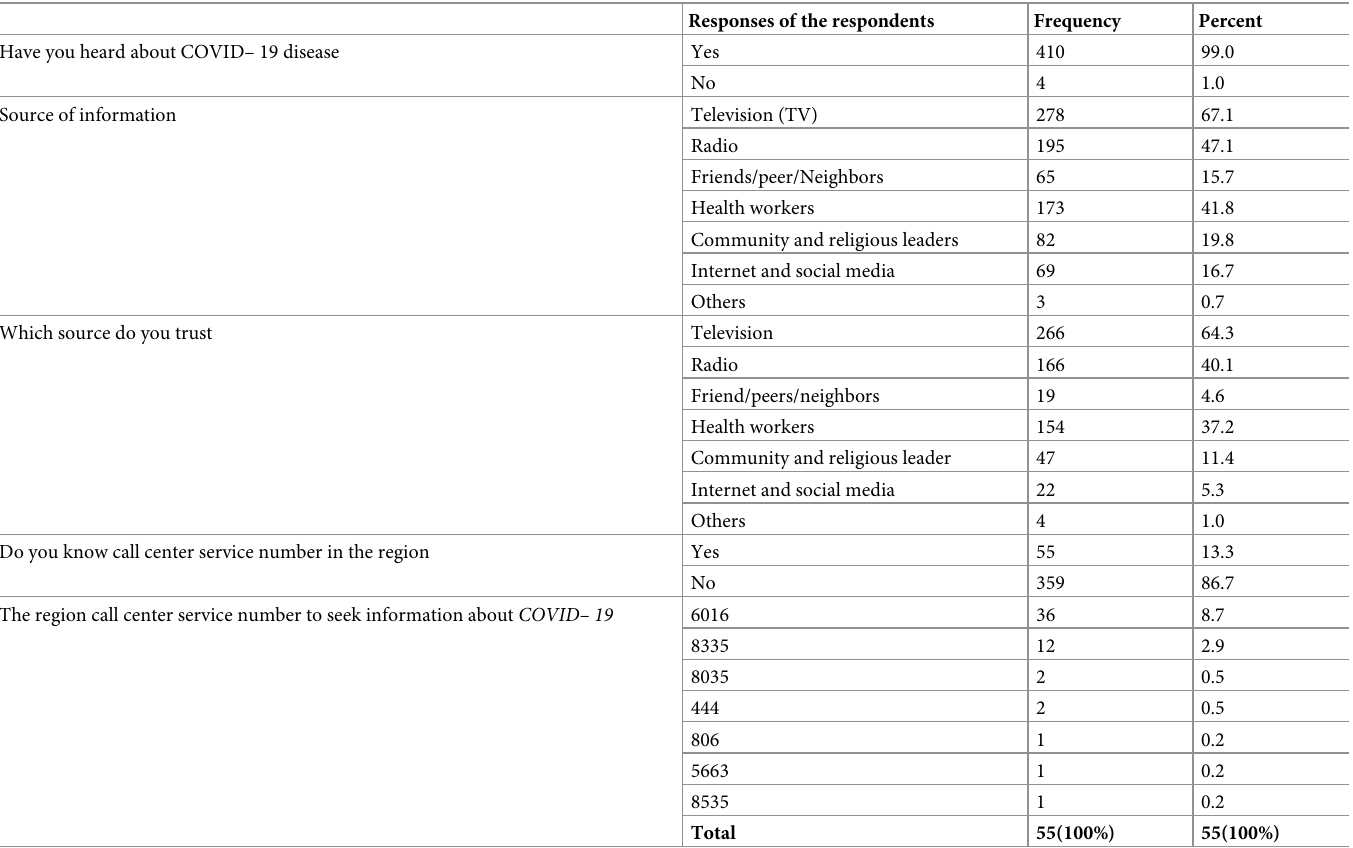
Table 2. Source of information and seeking modalities on COVID-19 infection in Benishangul Gumuz Region, Ethiopia,